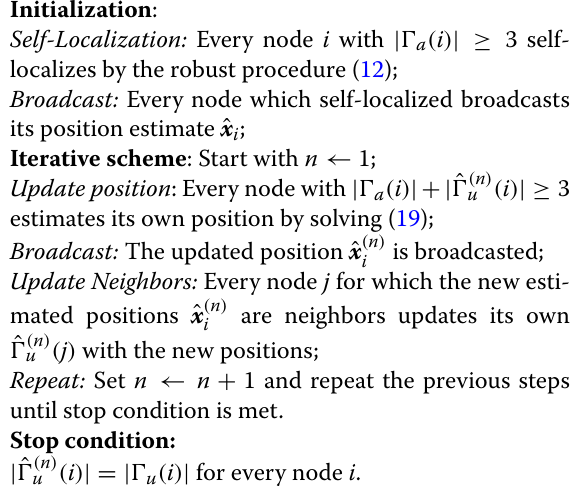
Algorithm 1 Robust distributed maximum